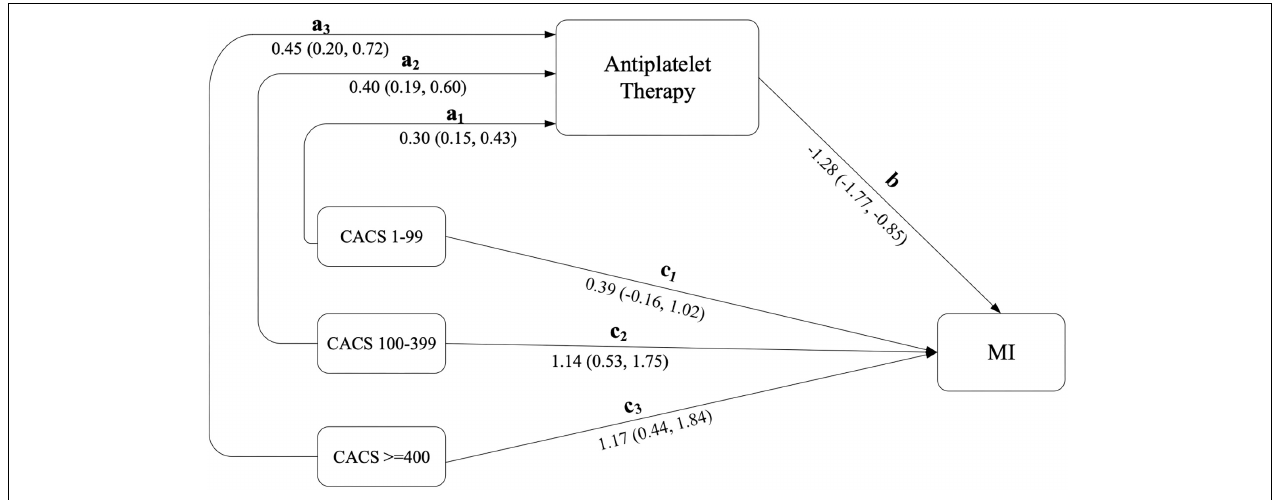
FIGURE 1 | Estimation of direct and mediation effects of CACS on MI through antiplatelet therapy. CACS, independent factor; MI, interested outcome; antiplatelet therapy, mediator. TABLE 4 | Estimation of direct and indirect effects of CAS on MI occurrence through antiplatelet treatments. Pathway Coef. 95% CI OR 95%